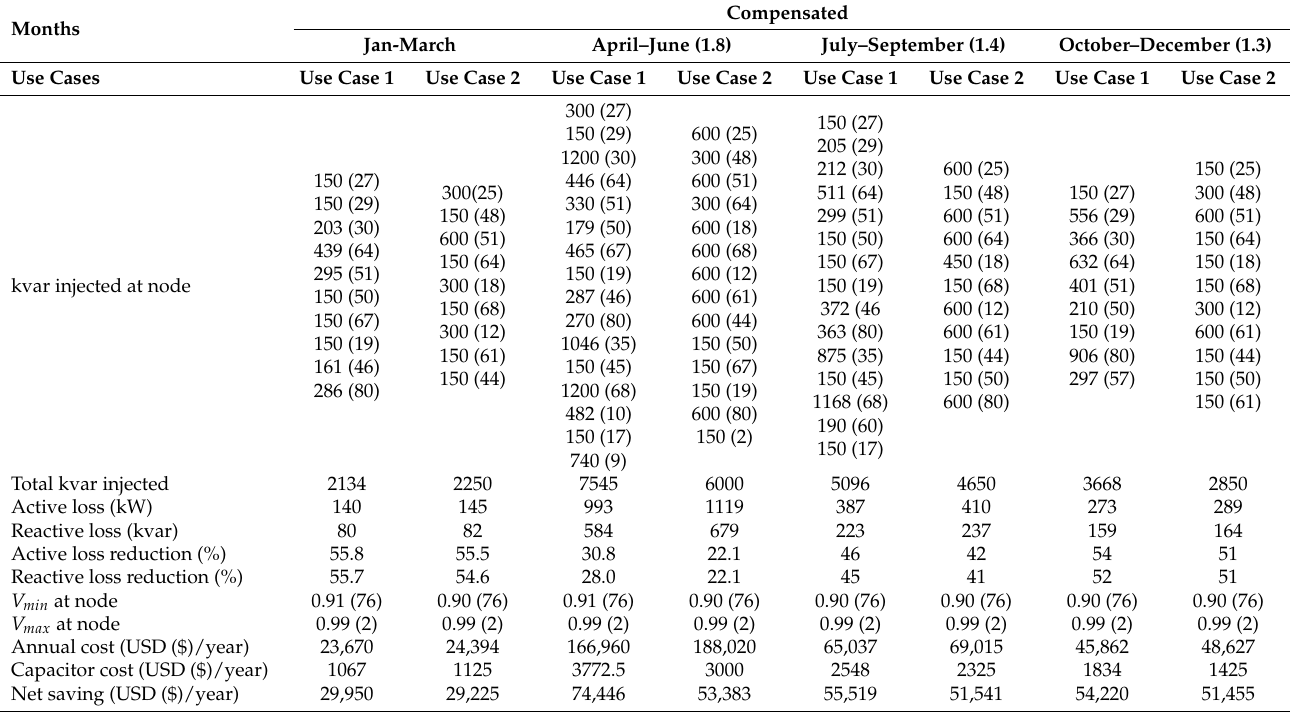
Table 9. Results comparison of N 2 for CS 2 (Scenario